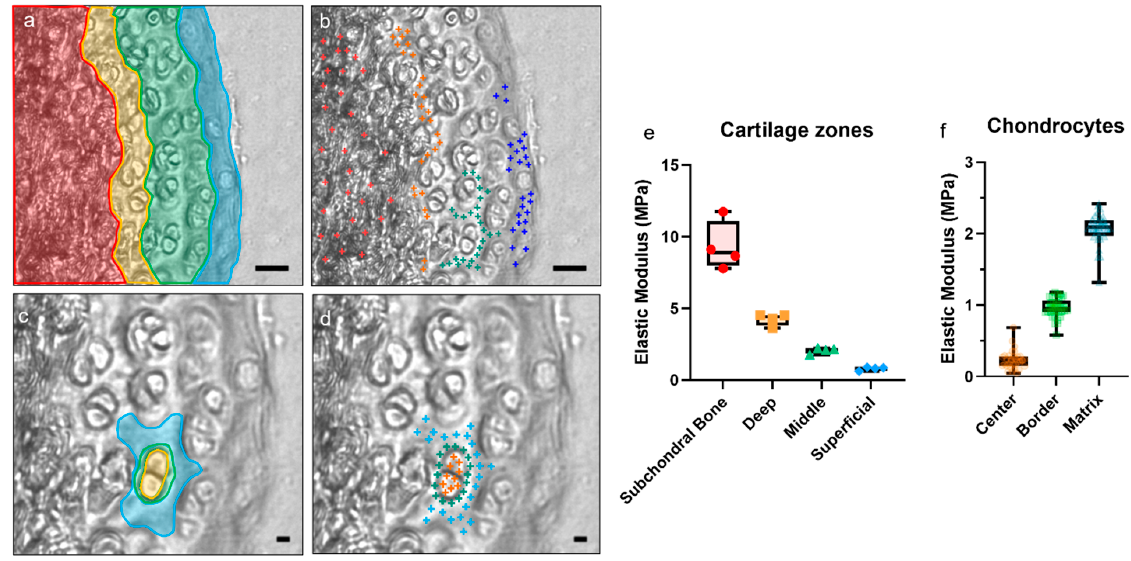
Figure 7. Elastic moduli vary by location in C57BL/6J murine articular cartilage. ( a ) Regions of cartilage and subchondral bone studied are pseudo-colored: Red = subchondral bone, orange = deep zone, green = middle zone, blue = superficial zone. Scale bar = 20 µm. ( b ) Actual points indented for each zone are indicated by colored plus signs. Scale bar = 20 µm. ( c ) Regions surrounding chondrocytes. Yellow = cells, green = pericellular region and cell membrane, blue = extracellular matrix. This figure shows one chondrocyte from one area; due to the proximity of some chondrocytes, adjacent chondrocytes such as those highlighted were considered a single cell. Two chondrocytes were analyzed in each area. Scale bar = 5 µm. ( d ) Actual points indented for each area surrounding the chondrocyte are indicated by plus signs. Scale bar = 5 µm. ( e ) Elastic moduli for each area of cartilage examined. Four animals were tested as biological replicates; each point represents the average for a single animal. ( f ) Elastic moduli for regions surrounding chondrocytes; each point is one cell.